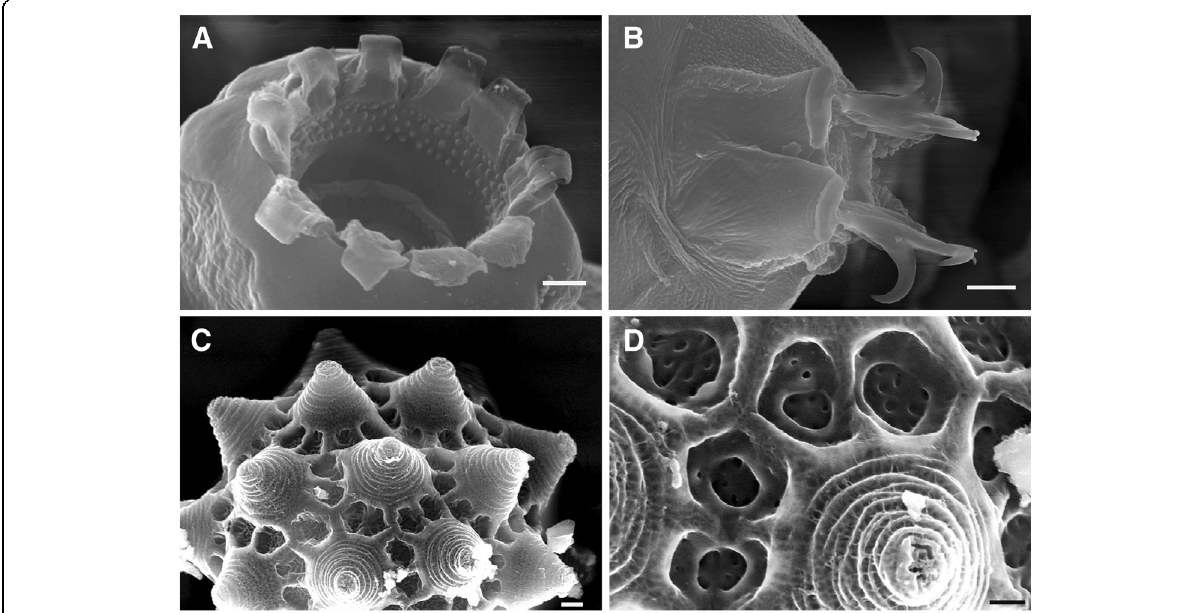
Fig. 10 Paramacrobiotus spatialis sp. n., paratypes from Formigine (SEM). a Peribuccal lamellae and anterior band of teeth. b Claws of the fourth pair of legs. c Egg processes. d Detail of the areolae around the egg process. Bars: a and d = 2 μ m, b and c = 5 μ